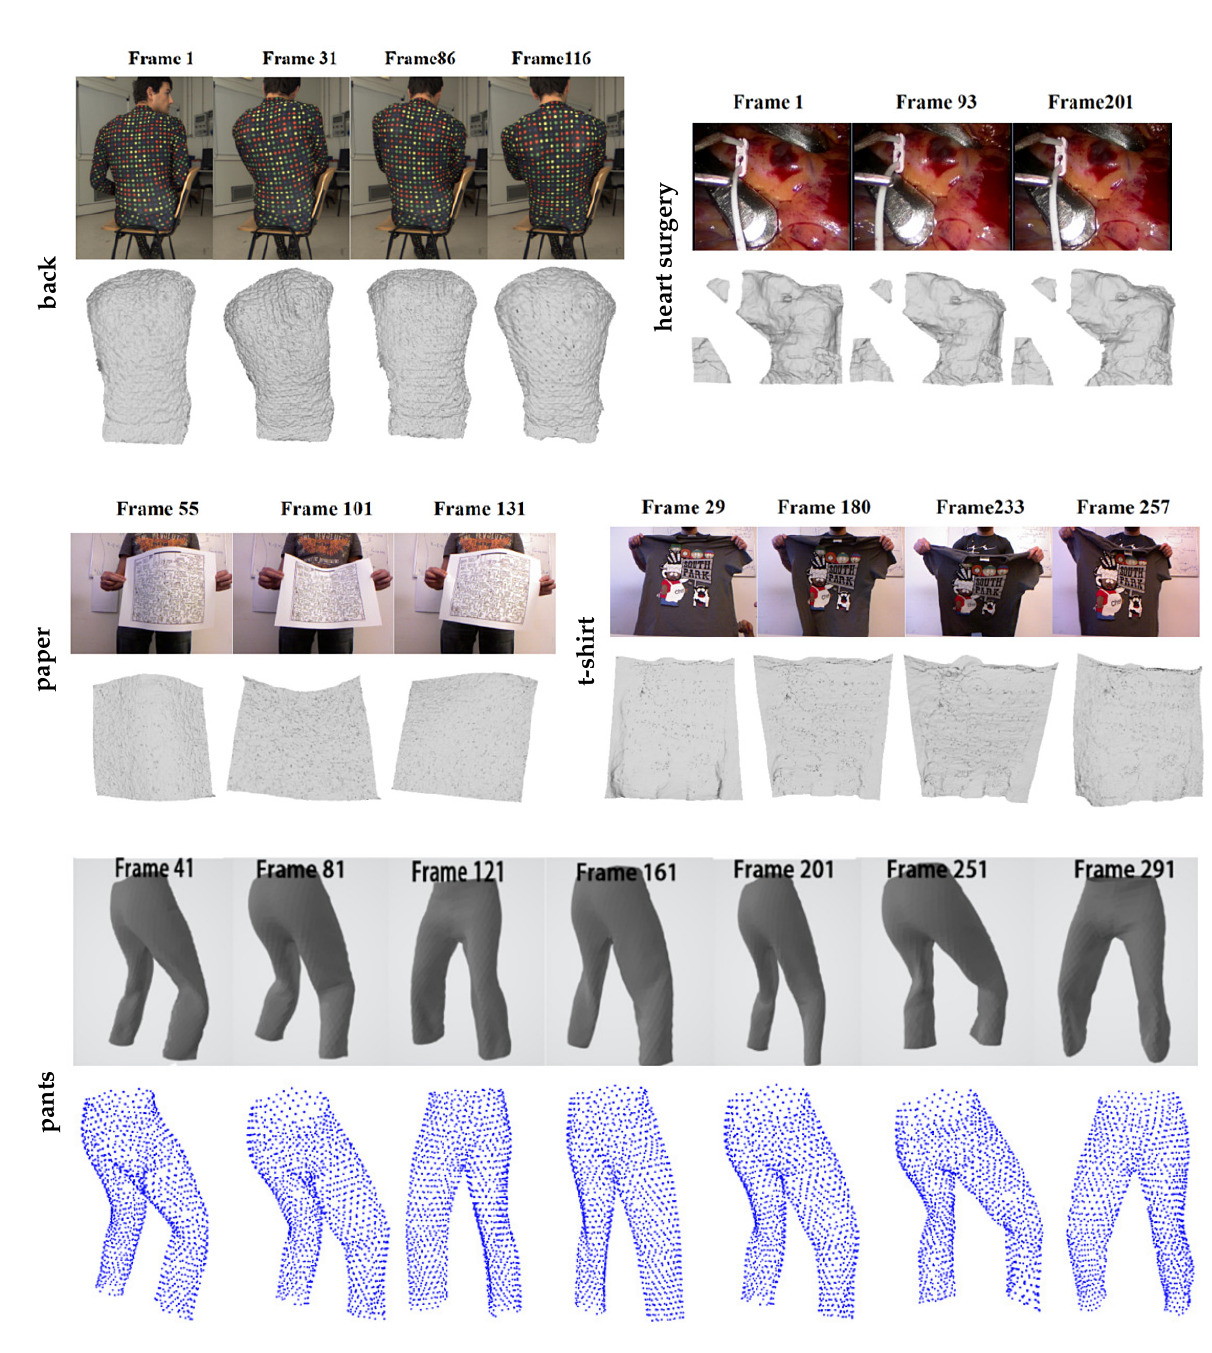
Figure 7. Visualizations of real sequence reconstruction results. The first row shows the reconstructed results of back and heart surgery sequences. The second row is the visualization of Kinect sequences’ reconstruction results. The third row shows the reconstruction effect of the heavily deformed sparse pants sequence, where DST-NRSfM achieves the lowest e 3 D among all examined approaches. The reconstruction result of the real face sequence is shown in Figure